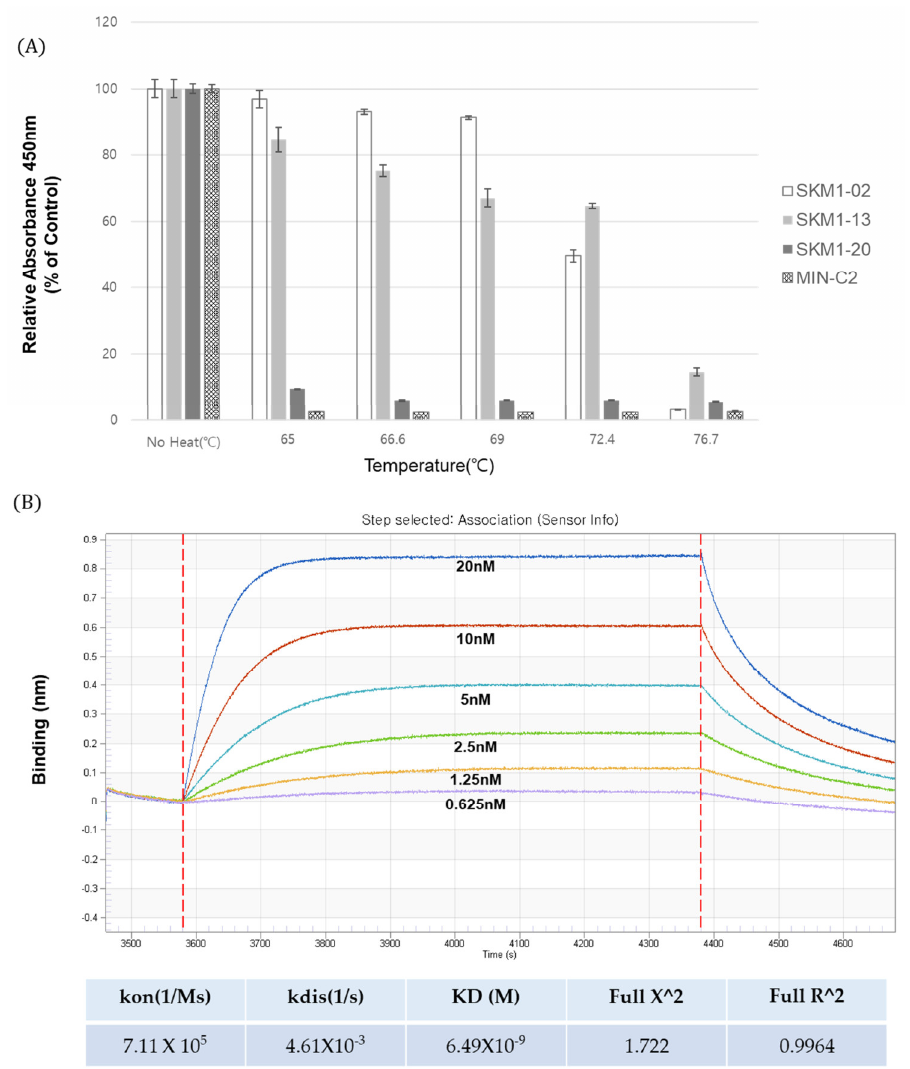
Figure 8. Thermal stability and binding affinity of anti-MUC1 antibodies. ( A ) Thermal stability testing of candidate antibodies. Anti-MUC1 antibody samples were incubated at incremental temperatures (65 °C~76.7 °C) for 10 min in a gradient PCR machine, and tested for binding to the MUC1 antigen in an ELISA assay. ( B ) The binding affinity of SKM1-02 with MUC1-C Ag (58AA ECD) was measured via biolayer interferometry using the Octet ® RED96 system. Increasing amounts of MUC1-C antigen were immobilized on an AR2G sensor chip, and antibodies were added. KD = equilibrium dissociation constant; K on = association rate constant; and K off = dissociation rate constant.